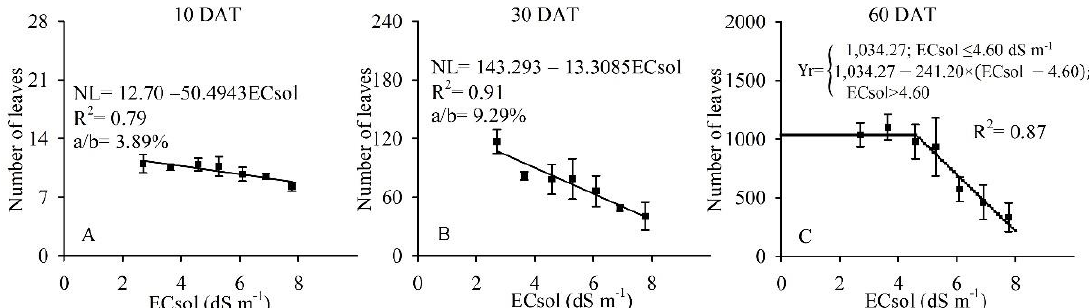
Figure 1. Mean number of leaves (NL) per plant at 10 ( A ), 30 ( B ), and 60 ( C ) days after transplanting (DAT) of “Biquinho” pepper cultivated in the hydroponic system as a function of the electrical conductivity of the nutrient solution salinity (ECsol).